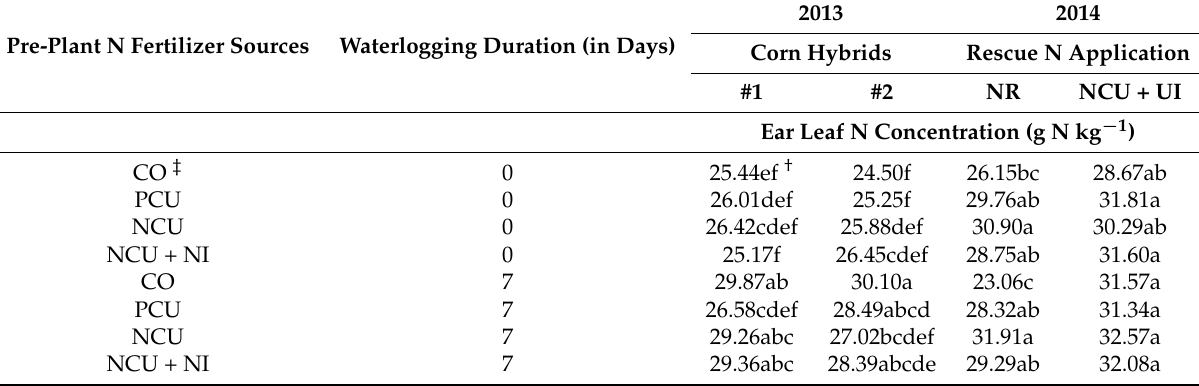
Table 4. Effects of waterlogging duration, corn hybrids, rescue N application and pre-plant N fertilizer sources on ear leaf N concentration in 2013 and 2014.